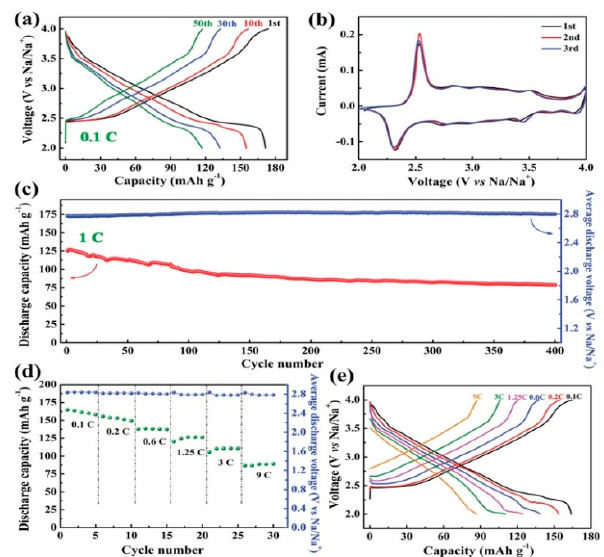
Figure 3. O3-LiNi 0.82 Co 0.12 Mn 0.06 O 2 cathode: ( a ) charge/discharge curves at 0.1C, ( b ) cyclic voltammogram curves at a scan rate of 0.05 mV s − 1 , ( c ) long-term cycle life and average discharge voltage at 1C, ( d ) discharge capacity and average discharge voltage, and ( e ) charge/discharge curves at different rates. Reproduced with permission from [90]. Copyright 2019 Wiley.